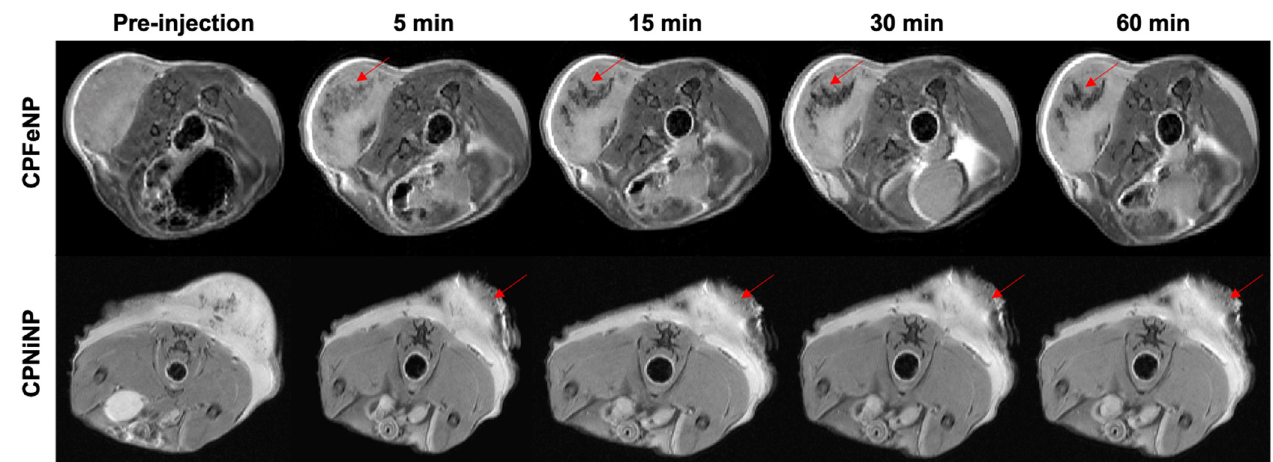
Figure 8. MRI monitoring after i.t. injection of IONP-doped CPNs in the flank. T 2 W axial images of the mouse body were acquired at 5, 15, 30 and 60 min after the i.t. nanoparticles injection. Red arrows point to the tumor region where injected nanoparticles (CPFeNP: upper panels, CPNiNP: lower panels) can be identified as a hypointense signal.